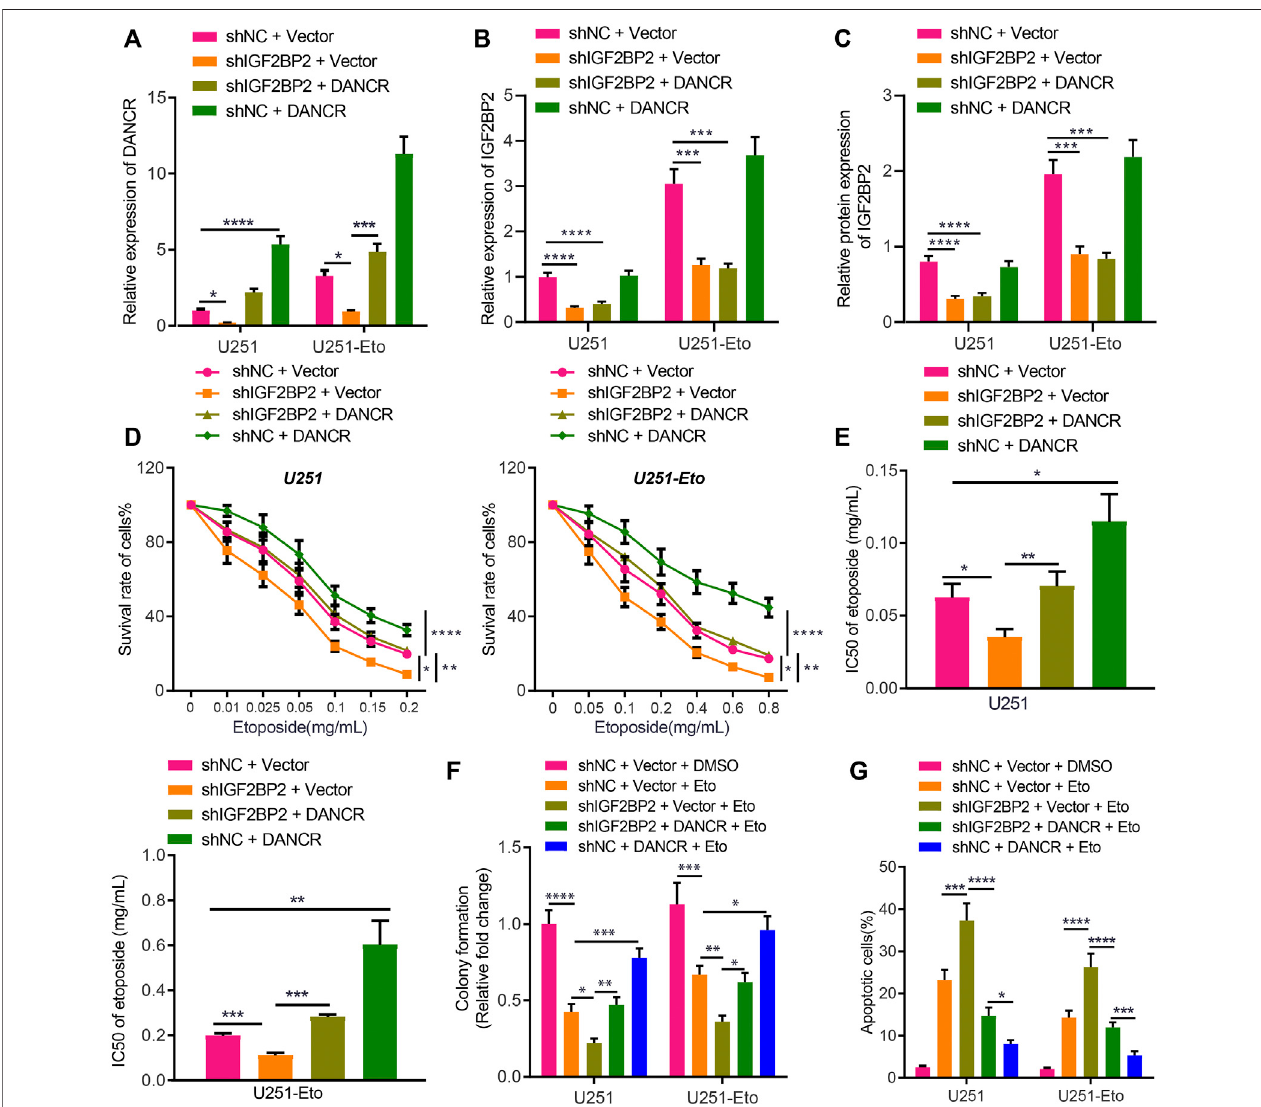
FIGURE3| IGF2BP2enhancesDANCRstabilityandinducesetoposideresistanceofGBMcells. (A) .RT-qPCRanalysisofDANCRmRNAexpressioninU251and U251-Eto cells upon treatment with sh-NC + vector, sh-IGF2BP2 + vector, sh-IGF2BP2 + DANCR, or sh-NC + DANCR. (B) RT-qPCR analysis of IGF2BP2